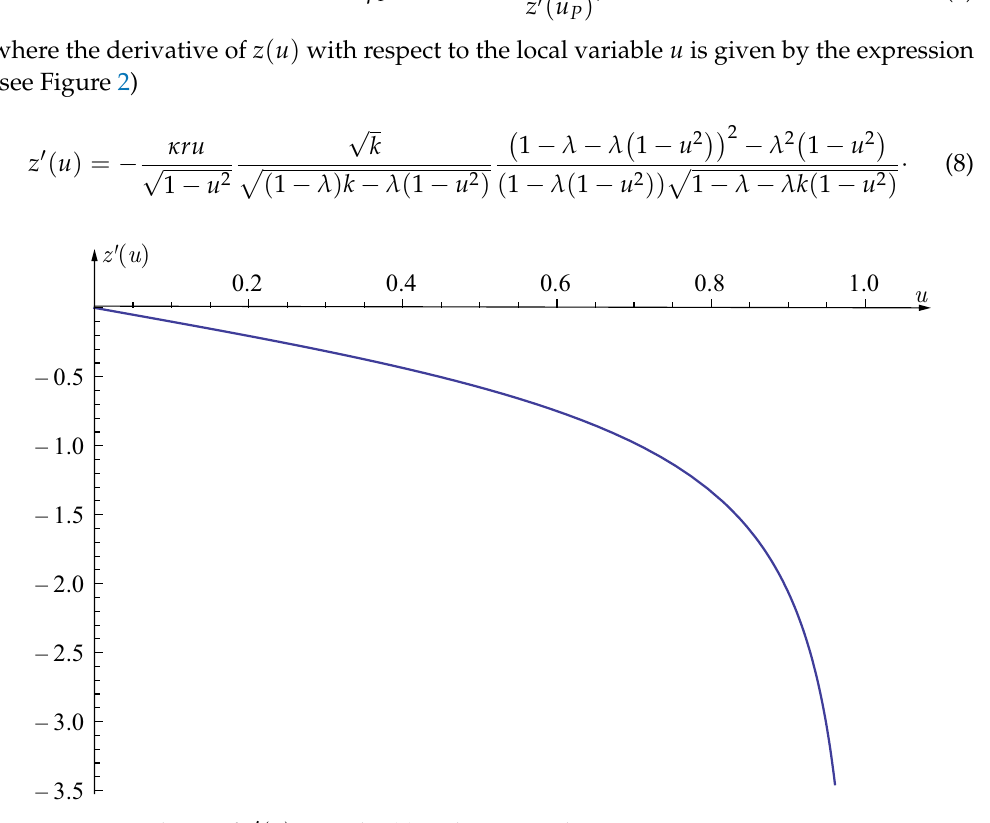
Figure 2. Dependency of z (cid:48) ( u ) given by (8) with κ = 1 and λ geoid =